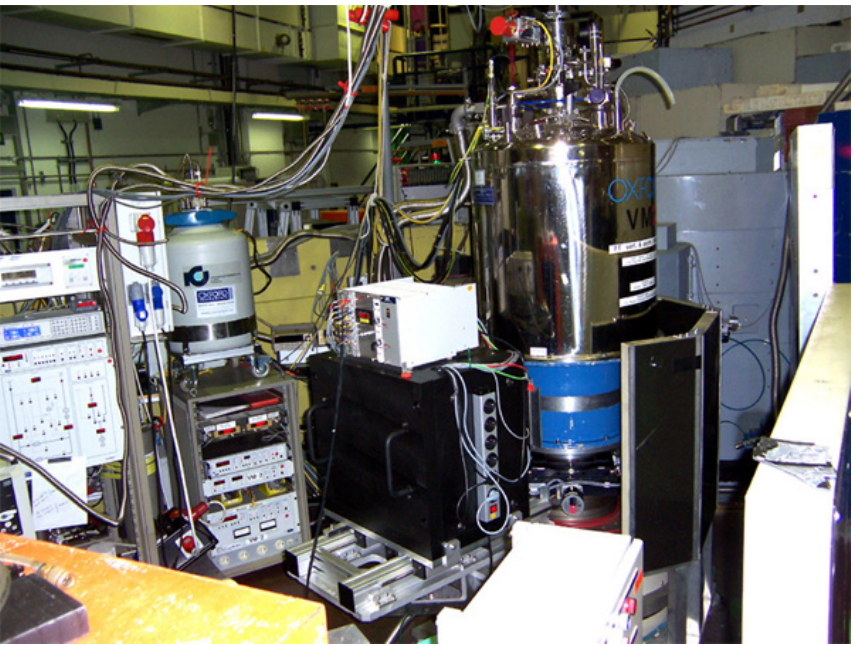
Figure 1: View of E4 with an extensive sample environment installed: the vertical cryomagnet and the dilution